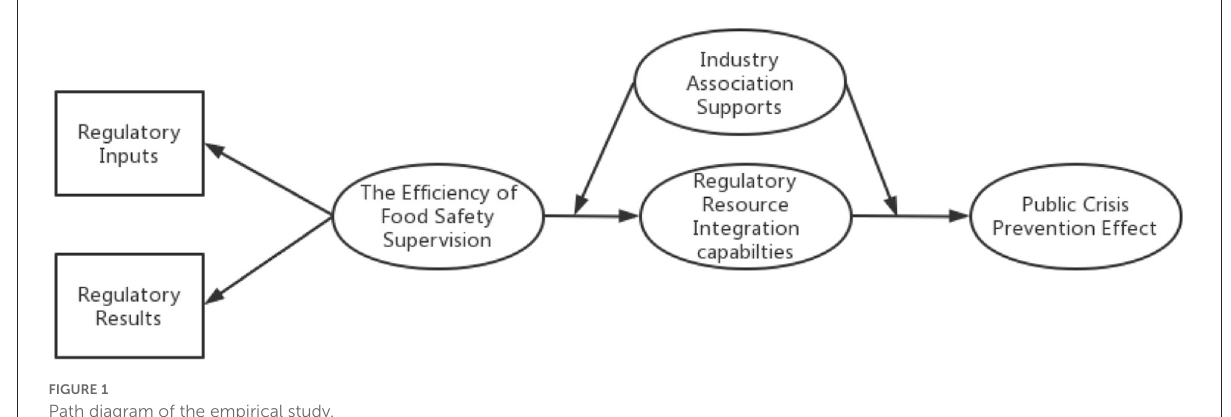
FIGURE1 Path diagram of the empirical study.